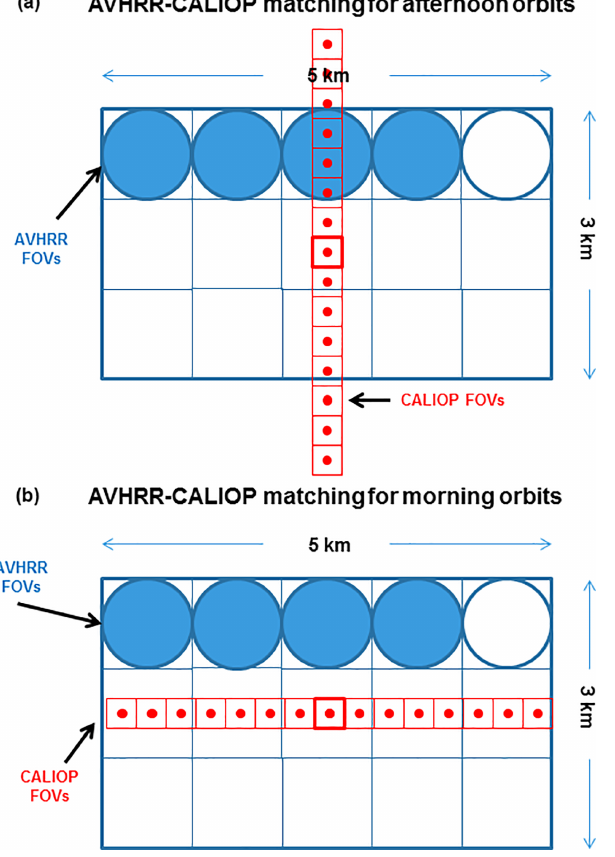
Figure 1. Matchup geometry for perfectly collocated AVHRR GAC and CALIOP FOVs for afternoon satellites (a) and morning satel- lites (b) . The GAC FOV is visualized as a rectangle with sides of 3 and 5km and with individual full-resolution AVHRR FOVs repre- sented as 1km squares. Blue circles indicate actual (more realistic) AVHRR measurements being used. Note that only the blue, filled AVHRR FOVs are averaged to represent the full GAC FOV. Red squares denote 15 original nominal 333m CALIOP FOVs which represent the CALIOP 5km FOV coverage. The highlighted centre FOV marks the position of the perfect match (i.e. at the centre of the GAC FOV). Note that the red, filled circles describe actual CALIOP measurements. See text for a more detailed